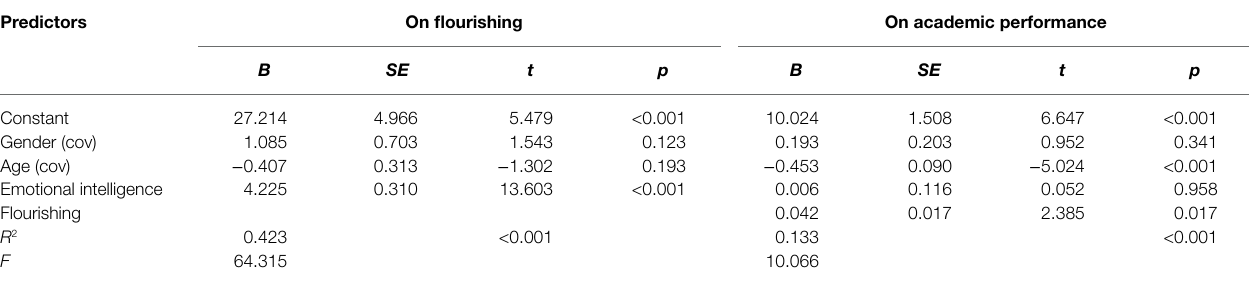
TABLE 2 | Mediating effect of flourishing on the association of emotional intelligence and academic performance. Predictors On flourishing On academic performance